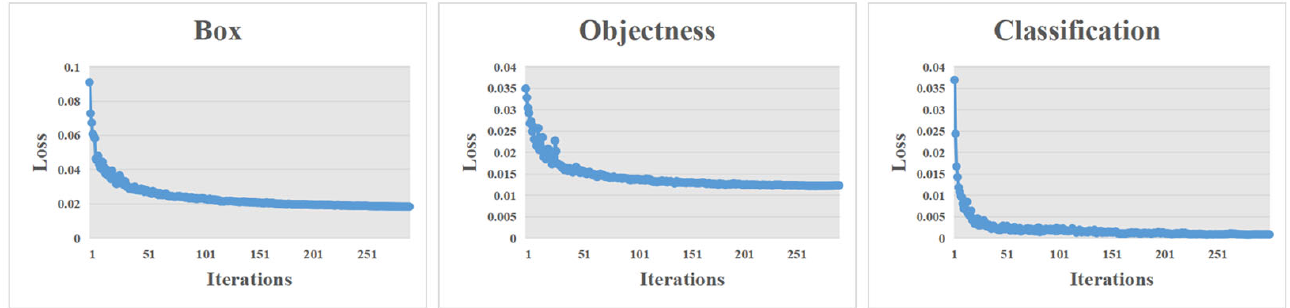
Figure 14. Variation curves of loss values on the Brackish dataset.